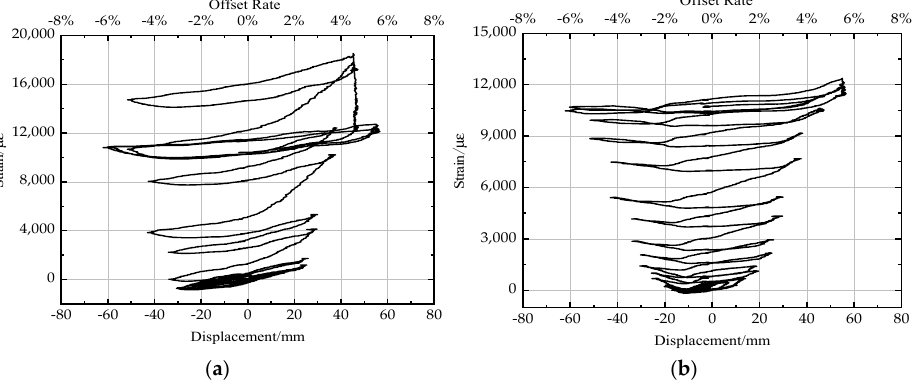
Figure 20. CFST-R specimen energy-consuming element strain, ( a ) Strain of East energy-consuming element, ( b ) Strain of West energy dissipation element.